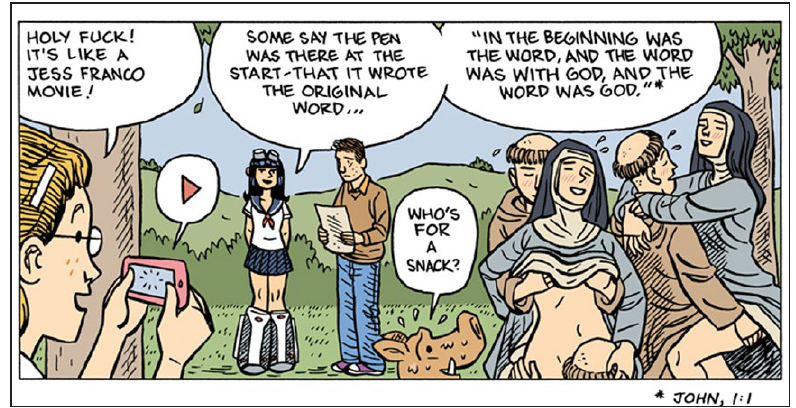
Figure 4: a ction button for action ( Sam Zabel and the Magic Pen : 142) © Dylan